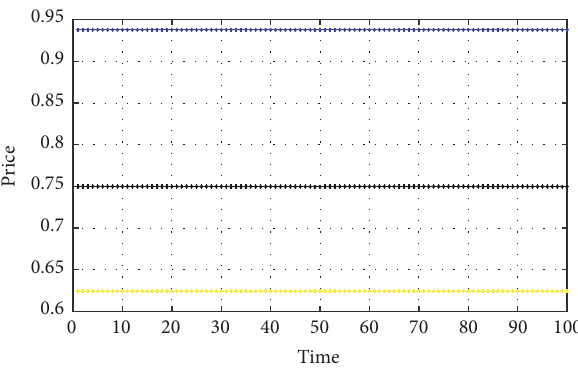
Figure 4: The price varies with the steady-state period of the game.